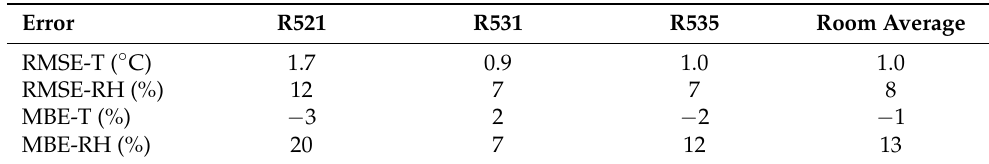
Figure 6. Comparison of indoor relative humidity of bedrooms (R523, R531, and R535) and their average value. Table 3. RMSE and MBE of temperature and relative humidity for bedrooms (523, 531, and 535) and their average value.